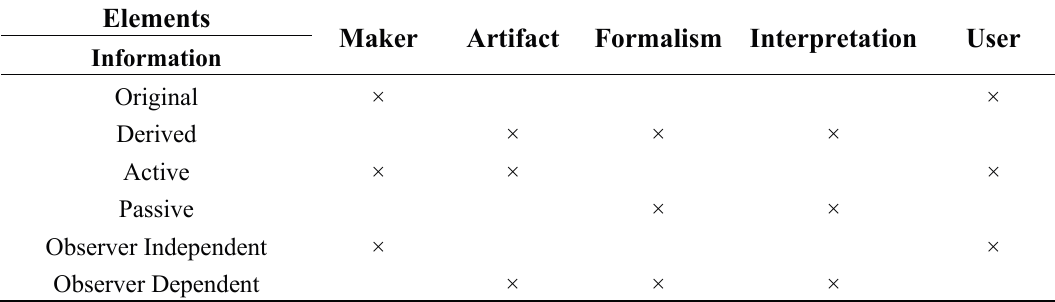
Table 1. Different elements involved in the production of an interpretation of quantum mechanics and its usage and the associated information in each